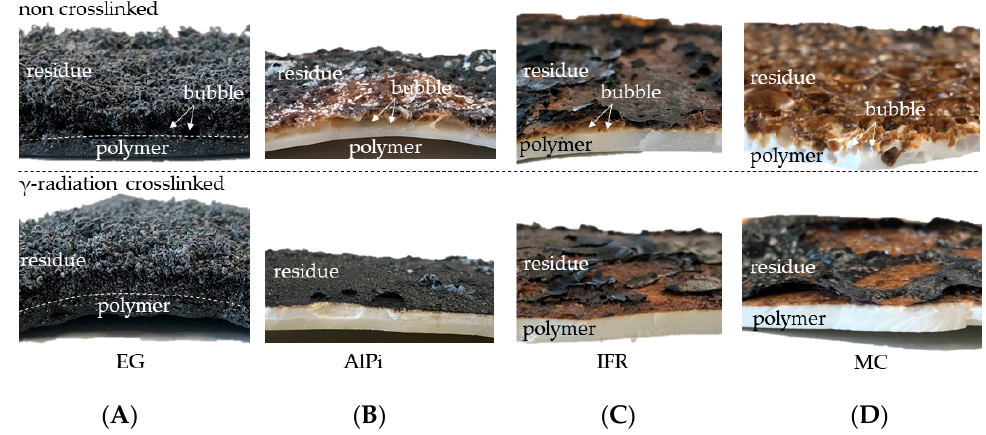
Figure 17. β -RC and non- β -RC samples extracted from cone calorimeter tests (50 kW/m 2 ) after 120 s. ( A ) PA6 + 20 wt.% EG; ( B ) PA6 + 20 wt.% AlPi; ( C ) PA6 + 20 wt.% IFR; ( D ) PA6 + 25 wt.% MC.